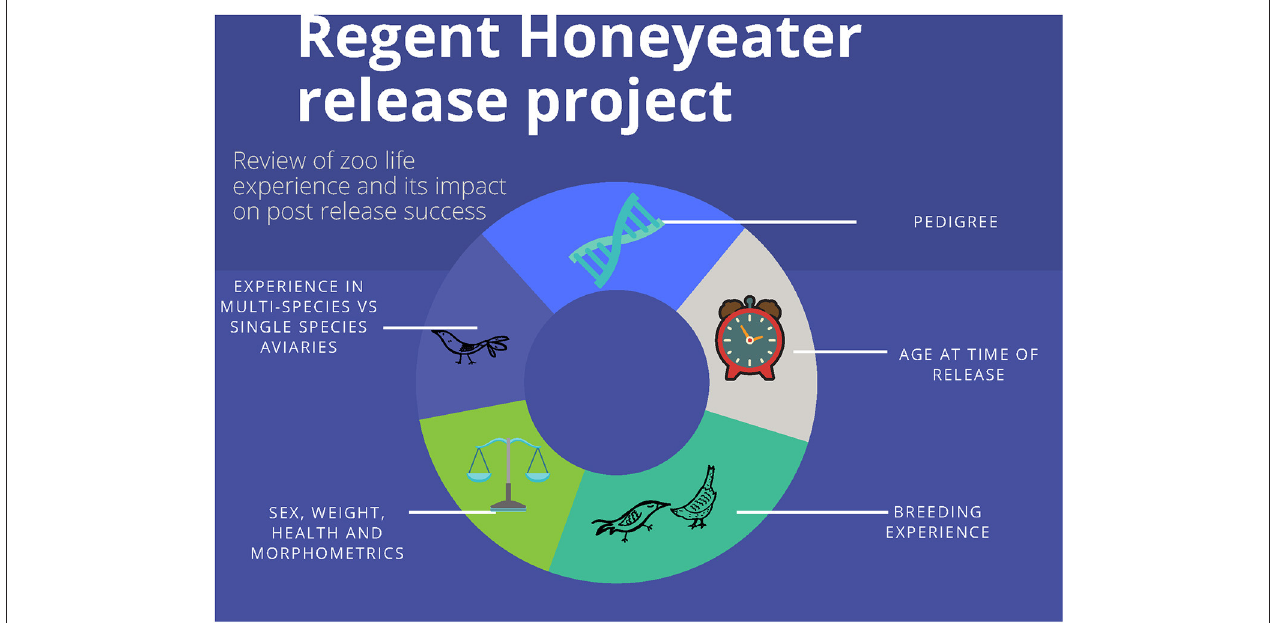
FIGURE 1 | Grouping of variables analysed by Regent Honeyeater release